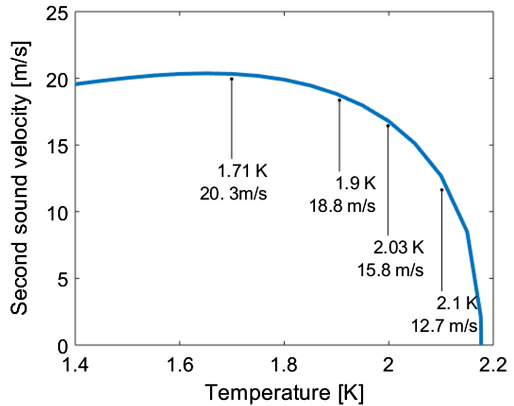
FIG. 7. Recommended values of the second sound velocity at different temperatures and values relevant for presented experi- ments, according to [29].